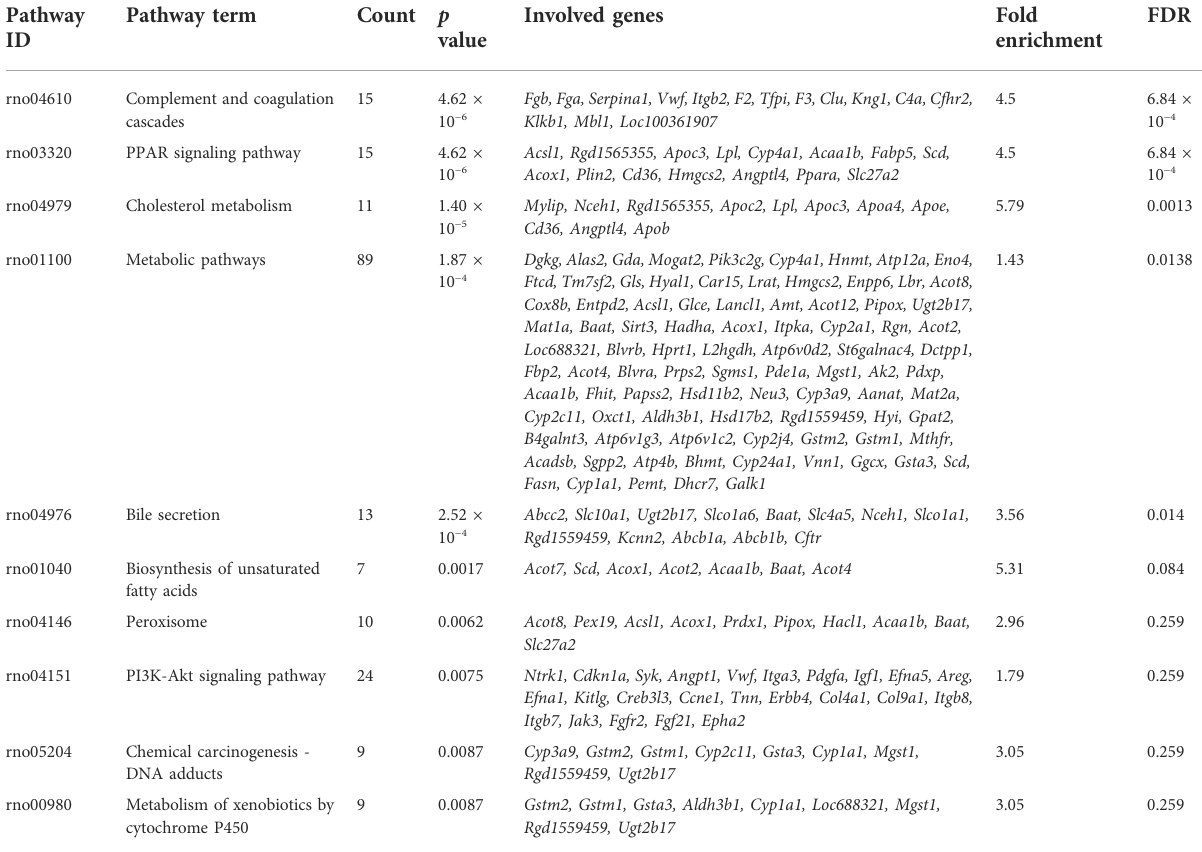
TABLE 3 Top 10 enriched KEGG pathways associated with differentially expressed genes in Bailing Capsule-treated group vs. DN group ( p < 0.01). Pathway